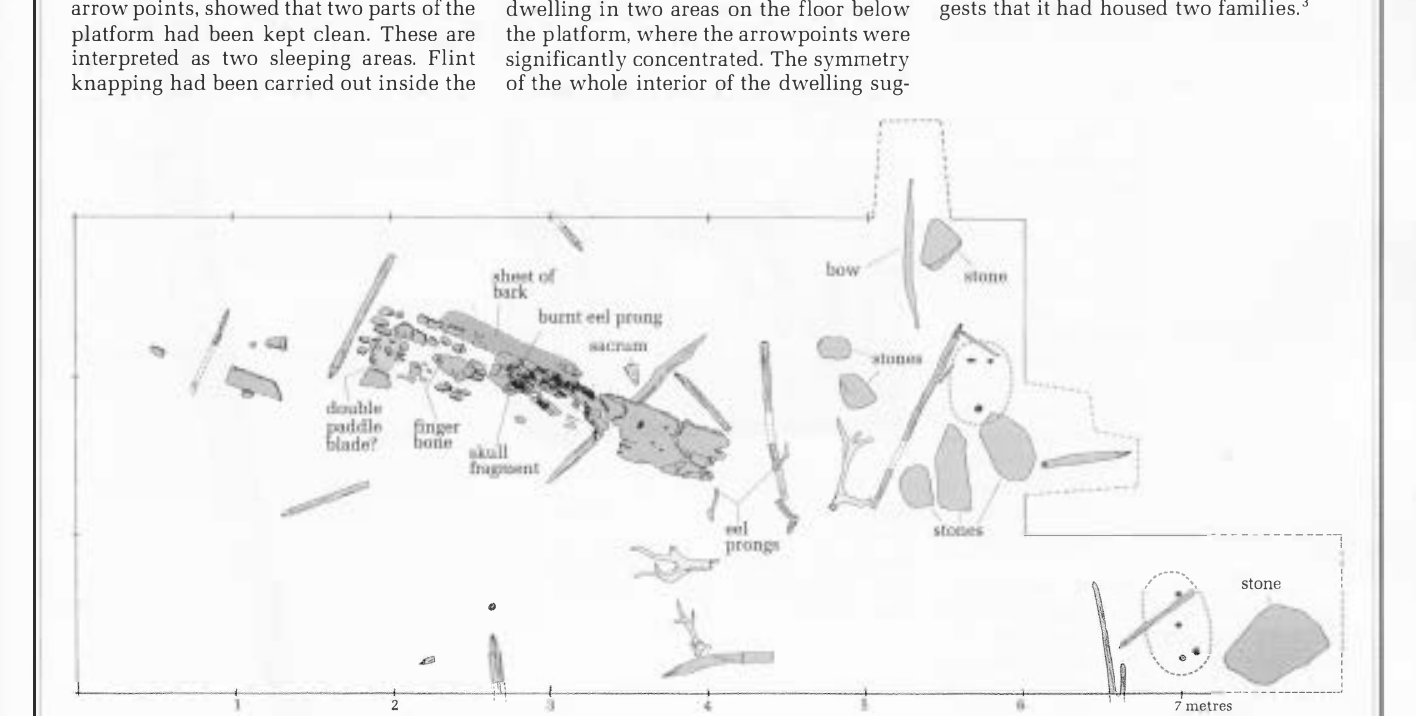
Figure 3 Plan of the Mollegabet II structure excavated under water in 1990-91 and interpreted as a Mesolithic burial in a dugout canoe that was probably originally placed above the ground on